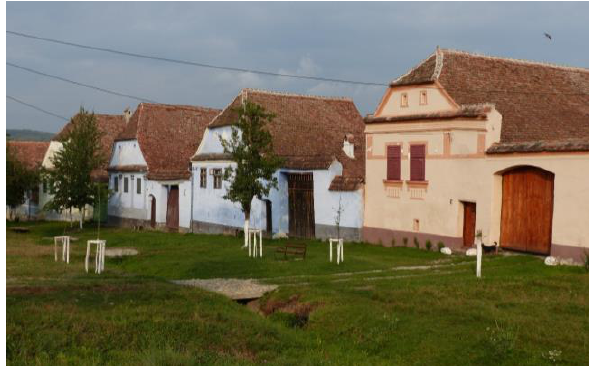
Figure 9. Dwellings in the main street of